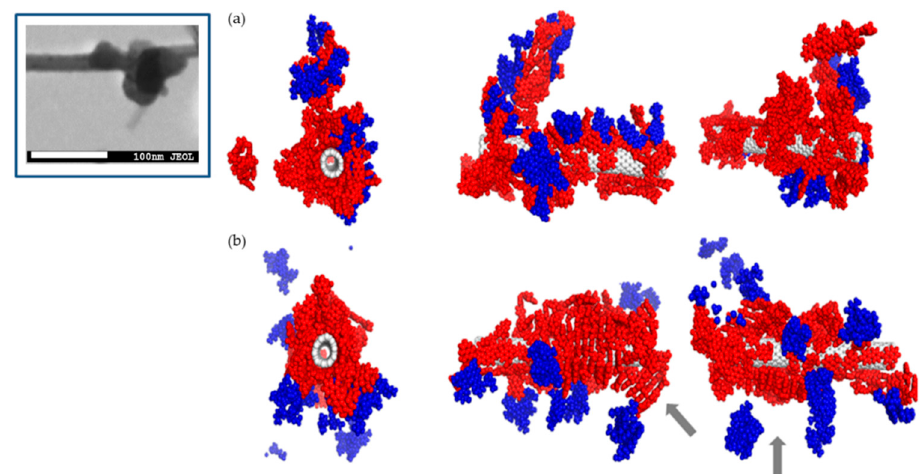
Figure 7. The structure of SWNT-CR-DOX systems at pH < 5.0. ( a ) system composed of SWNT (10.0), 20 CR molecules (red) and 10 DOX molecules (blue), arrows show ribbon-like CR structure; ( b ) system composed of SWNT (30.0), 20 CR molecules and 10 DOX molecules; ( c ) system composed of SWNT (30.0), 40 CR molecules and 10 DOX molecules. Ionic strength of the solution was 0.145 M.